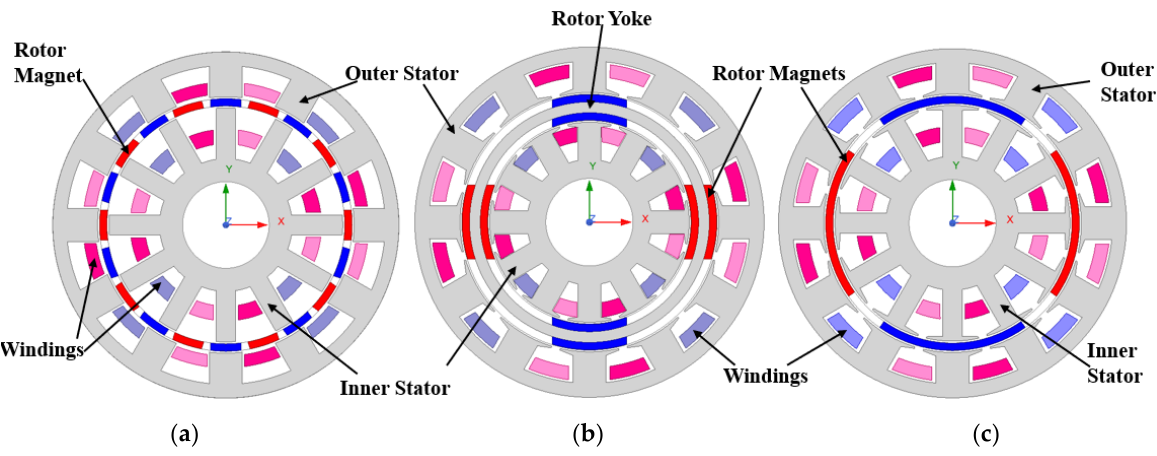
Figure 13. DARF PM machines: ( a ) PMVM yokeless, ( b ) PMSM with iron yoke rotor, ( c ) PMSM with yokeless rotor. Table 3. Performance comparison of DARF-PMVM with iron yoke and yokeless rotor models.